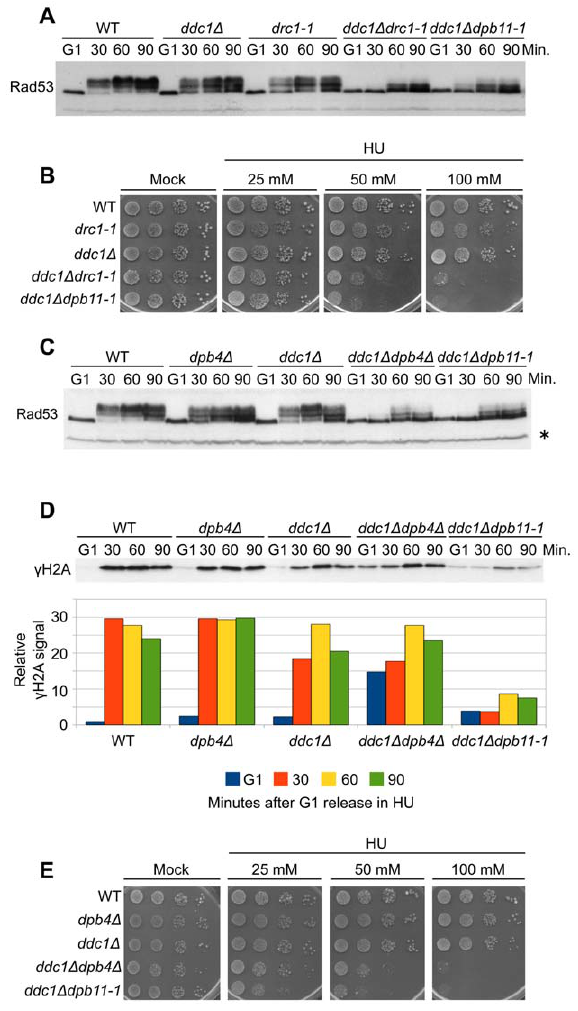
Figure 5. Pol e associated proteins are involved in the 9-1-1– independent checkpoint signaling branch. (A) Strains K699 (WT), Y799 ( drc1-1 ), YAN21/8d ( ddc1 D ), YFP218/1a ( ddc1 D drc1-1 ) and YFP62/1d ( ddc1 D dpb11-1 ) were cultured to mid-log phase, synchronized in G1 with a -factor and released into fresh medium supplemented with 200 mM HU. At the indicated time-points Rad53 phosphorylation was assayed by SDS- PAGE and Western blotting. (B) Ten-fold serial dilutions of overnight cultures of the strains in panel A were spotted on YPD plates supple- mented with HU at the indicated concentration. Survival was assayed by monitoring cell growth after 6 days. (C) Strains K699 (WT), YFP167/1a ( dpb4 D ), YAN21/8d ( ddc1 D ), YFP206/1a ( ddc1 D dpb4 D ) and YFP62/1d ( ddc1 D dpb11-1 ) were cultured to mid-log phase, synchronized in G1 with a -factor and released into fresh medium supplemented with 200 mM HU. Attheindicatedtime-points,proteinextracts were preparedandseparated bySDS-PAGE. Rad53 phosphorylation was assayed bywestern blotting. (D) The same filter was probed for Mec1 activity by testing histone H2A phosphorylation. A quantification of c H2A, using a -Rad53 cross reacting band as loading control is shown in the lower panel. The values indicate the fold increase respect to the WT G1 sample. (E) Ten-fold serial dilutions of overnight cultures of the strains in panel C were spotted on YPD plates supplemented with HU at the indicated concentration. Cell survival was assayed monitoring cell growth after 6 days. In all the relevant panels the loading control is indicated by an asterisk. [7,12]. Accordingly, the HU sensitivity of ddc1 D dpb11-1 double mutant cells, differently from that of a mec1-1sml1 strain, is not detectable in the case of transient HU treatment. This